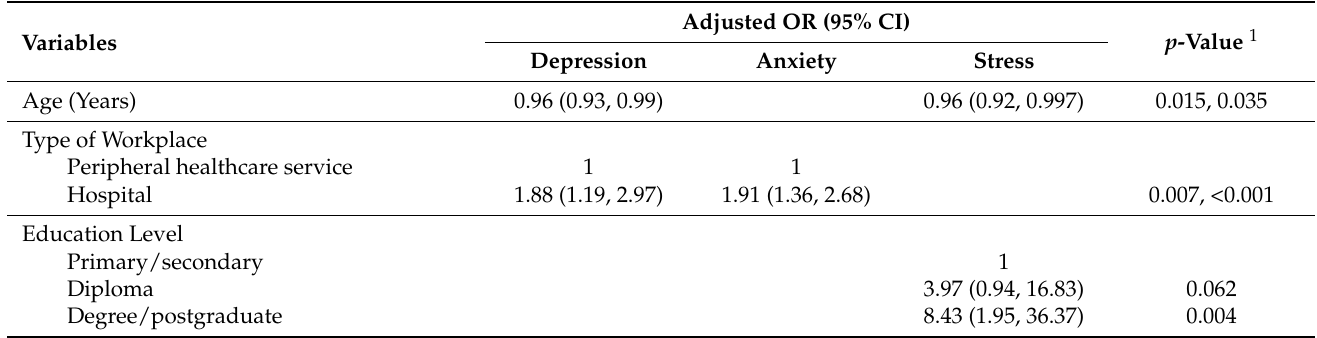
Table 3. Factors associated with depression, anxiety, and stress ( n =